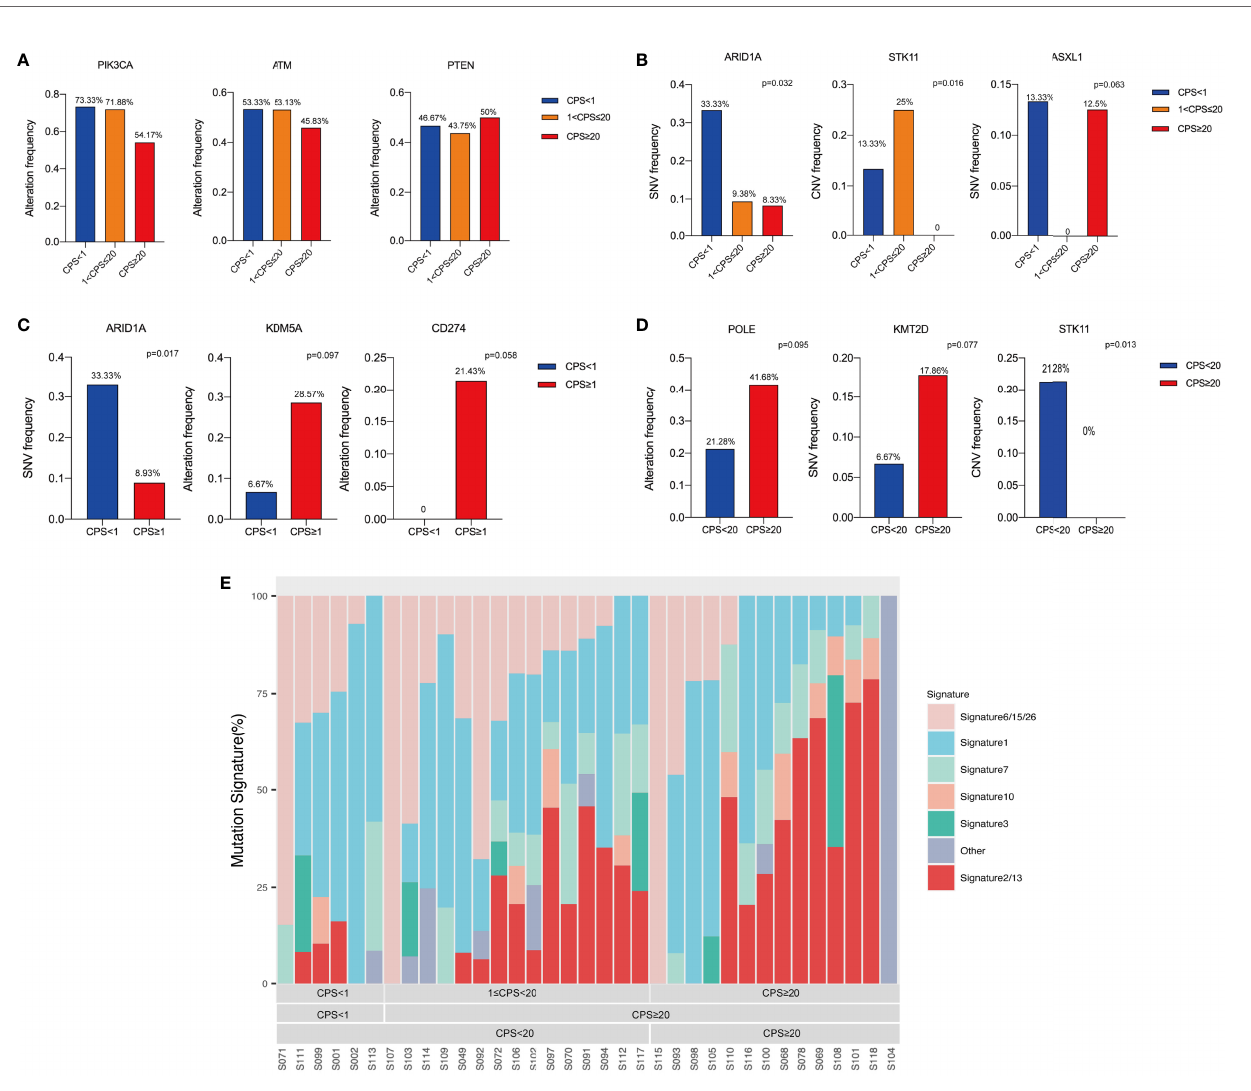
FIGURE 6 | Genomic alterations analysis based on CPS levels. (A) The top common altered genes. (B) Altered genes among different CPS groups classi fi ed by methodology A. (C) Altered genes between different CPS groups classi fi ed by methodology B. (D) Altered genes between different CPS groups classi fi ed by methodology C. (E) Mutation signature analysis based on CPS